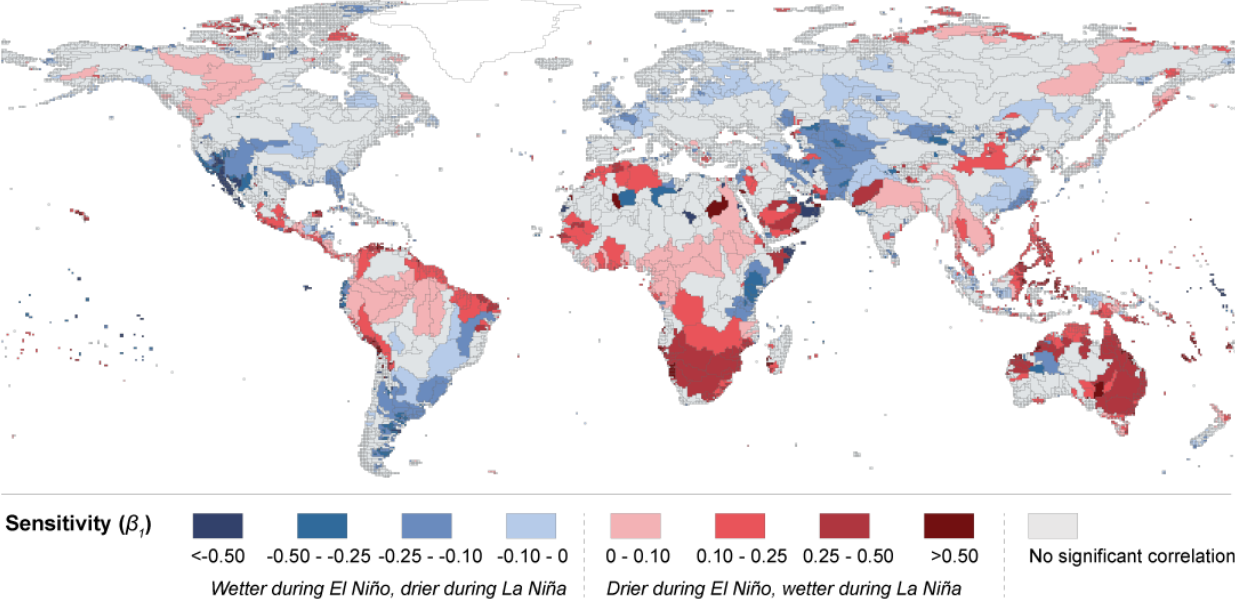
Fig. A6. Sensitivity ( β 1) of ln Q ann to variations in SOI (Pearson’s r , t statistic, α = 0 . 10). Negative correlation generally represents wetter conditions in El Niño years/drier conditions in La Niña years, while positive correlation generally represents the opposite.